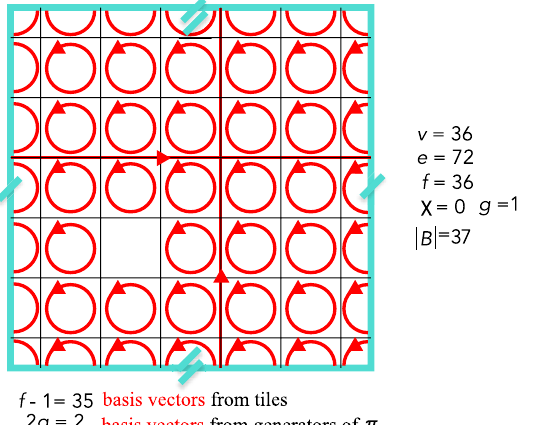
FIG. 2. Tiles and topological cycles of a square lattice on a toroidal topology ( g ¼ 1 ). Opposite sides of the lattice are identified as